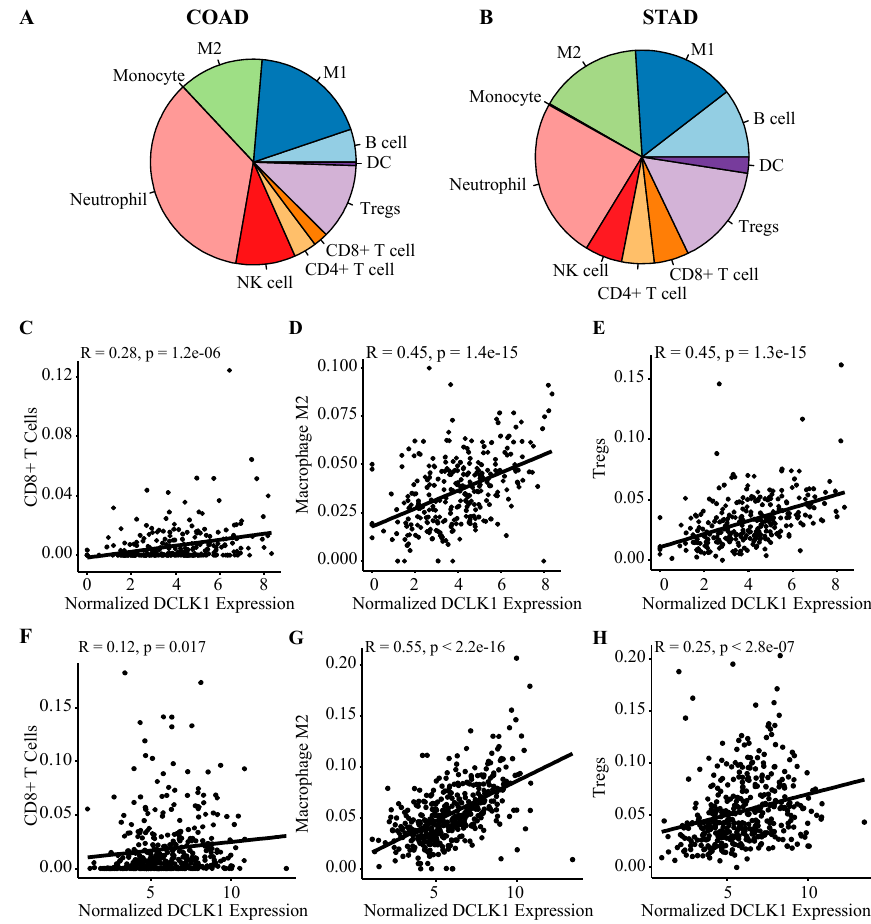
Figure 3. DCLK1 mRNA expression in tumor tissues is significantly correlated with immune infiltration. Estimated fraction of immune cells in tumor tissues of COAD ( A ) and STAD ( B ) was visualized by QuanTIseq analysis. Among all the immune cell types, macrophages (M1 + M2) represented the